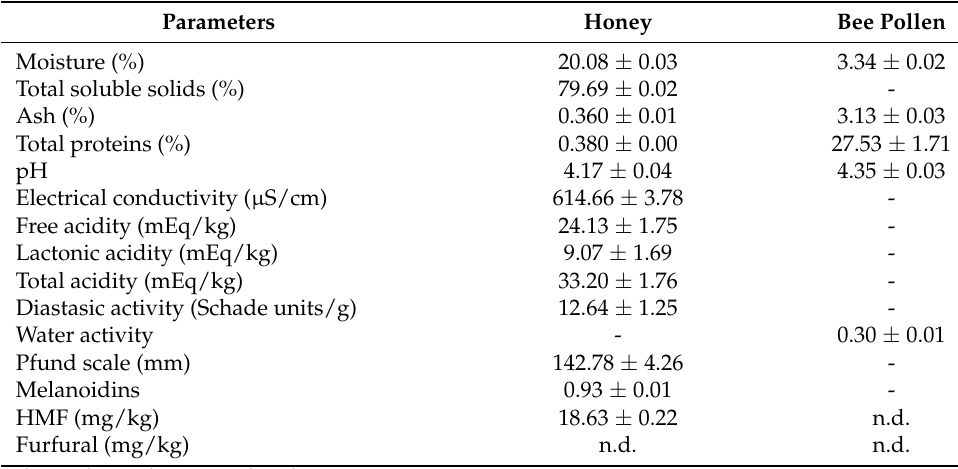
Table 3. Physicochemical parameters of honey and bee